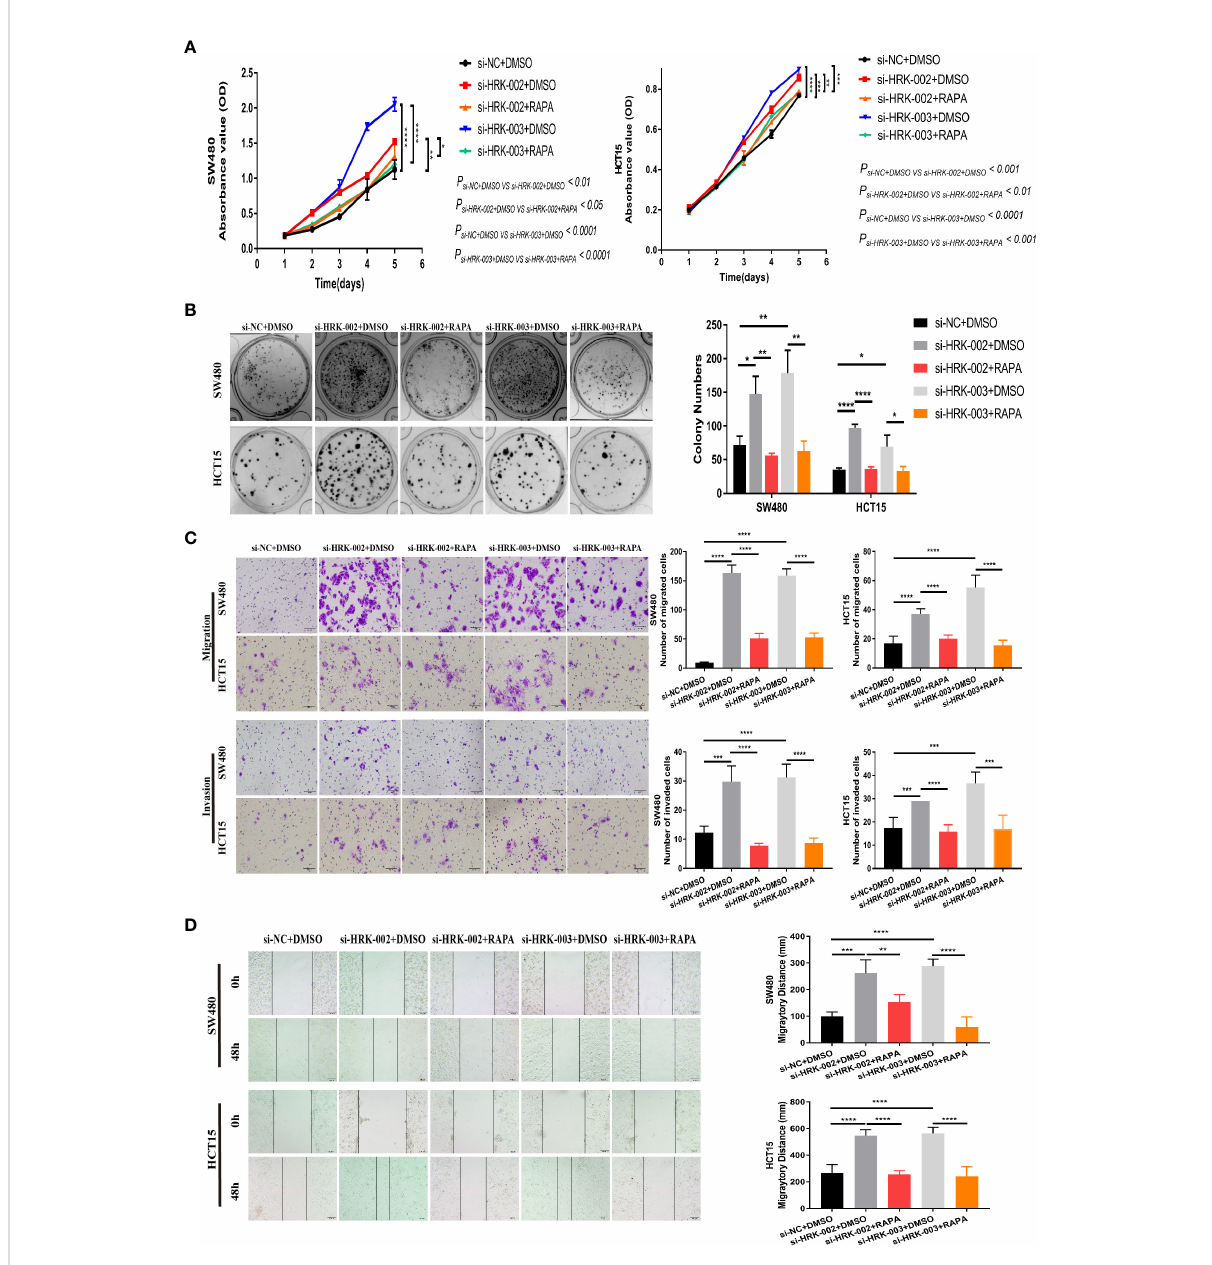
FIGURE 7 In vitro proliferation, invasion and migration ability of HRK expression-reduced cell lines were inhibited by rapamycin. A, B, CCK-8 (A) and colony formation assays (B) were used to evaluate the proliferation of CRC cells after HRK reduction or RAPA (100 nM) treatment for 24 h. (C) , Matrigel transwell assays and Matrigel-free transwell assays were used to evaluate the invasion and migration ability of CRC cells after HRK knockdown or RAPA (100 nM) treatment for 24 h. (D) , Wound-healing assay were used to evaluate the migration ability of CRC cells after HRK knockdown or RAPA (100 nM) treatment for 24 h. Data are expressed as the means ± SD in 3 independent experiments. * P < 0.05, ** P < 0.01, *** P < 0.001 and **** P <